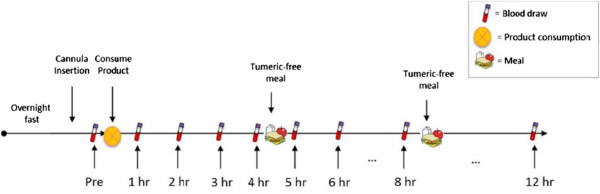
Schematic representation of the study procedure.